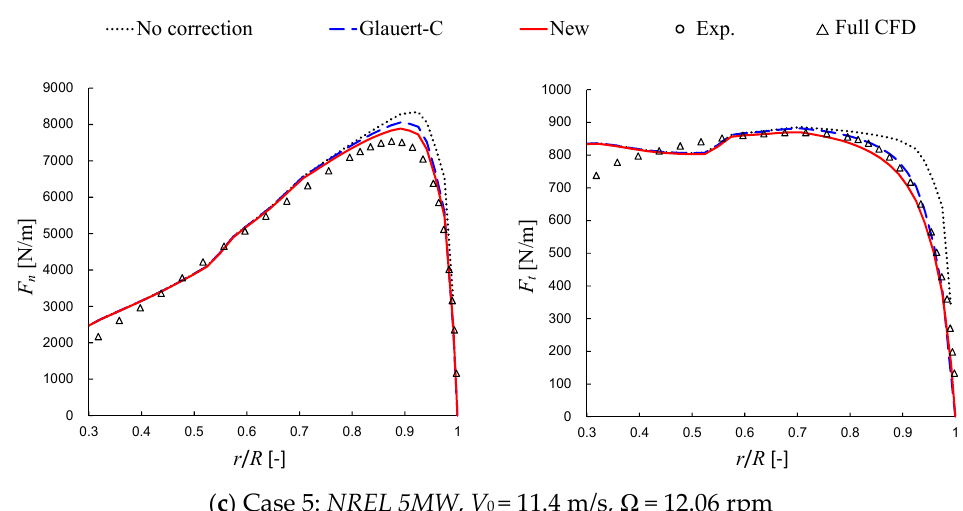
Figure 8. Normal force F n and tangential force F t along the NREL 5MW blade.